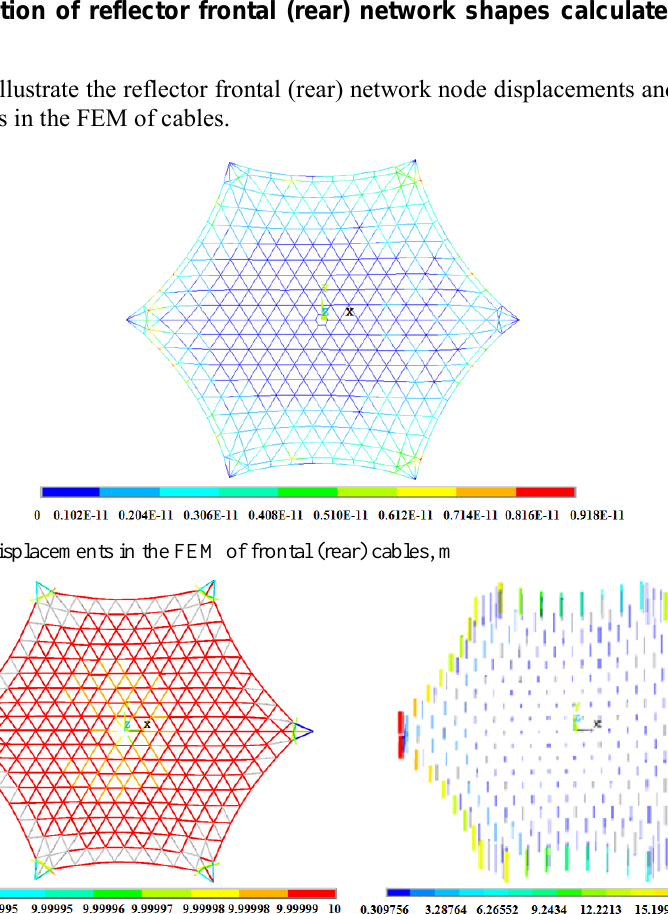
Fig. 7. Tension distribution in the FEM of frontal (rear) nets and tension ties, N It is apparent that node displacements are practically zero, while the tension values of frontal (rear) cable elements are close to required value 10N. So, the obtained solution of equations (1) is